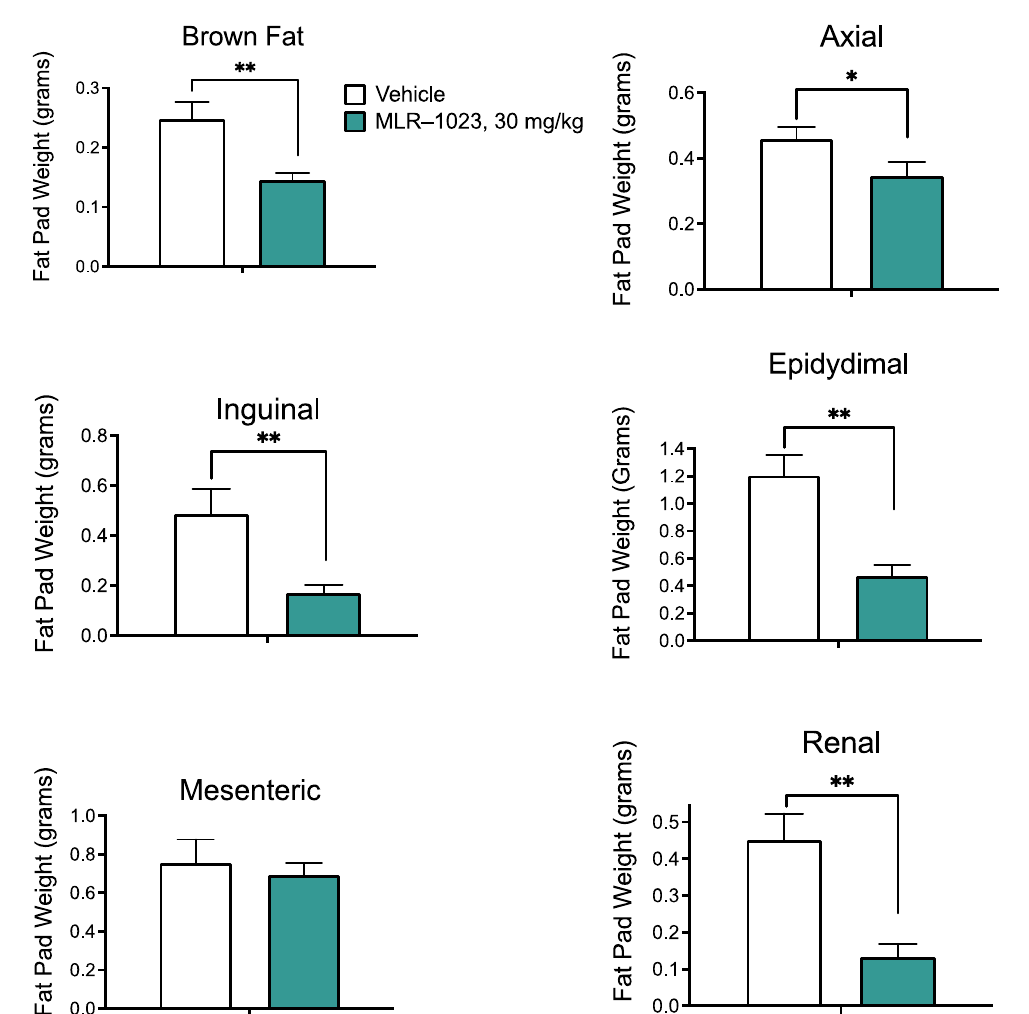
Figure 1. Effect of 30 mg/kg of MLR-1023 twice daily on body weight and food intake in CD1/ICR mice. The mice were weighed daily, and food intake was monitored every one to four days. ( A ) Weight change from day 0 to day 31 ( B ) Food intake from day 1 to day 31. N = 6 per group. Values are mean ± SEM. * p < 0.05.